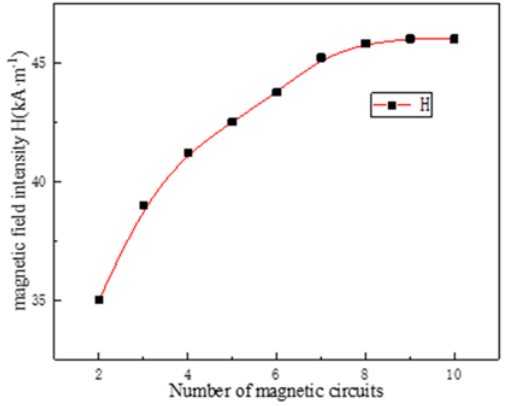
Figure 12. Field strength growth trend.